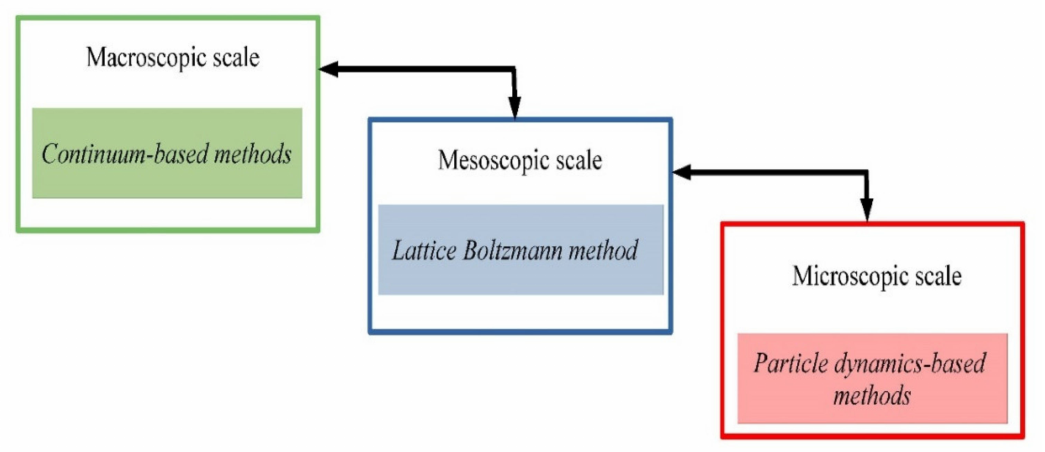
Figure 1. A hierarchy of scales and simulation